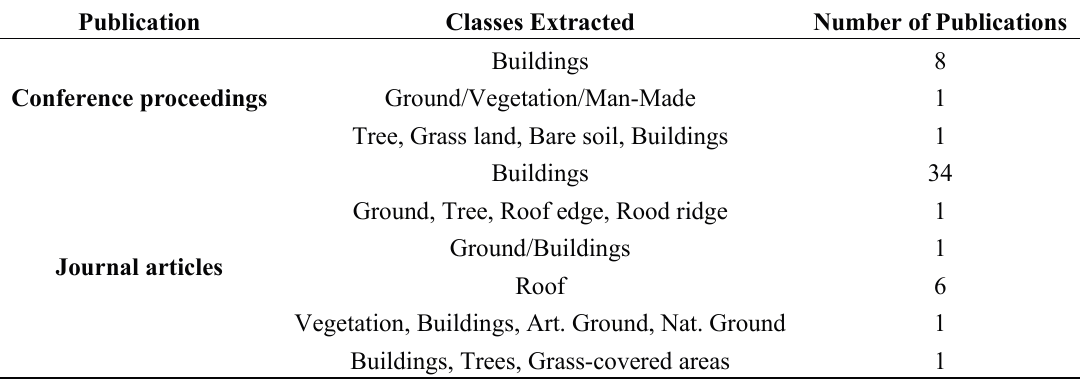
Table 2. Overview of type of selected publications and final output classes used for extraction of data based on WoS and Scopus search